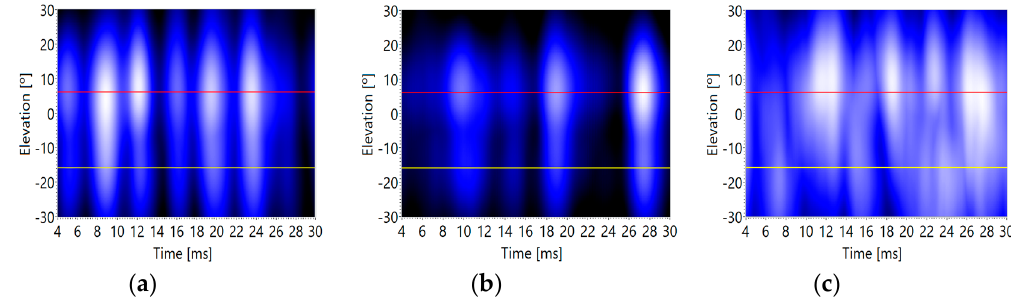
Figure 14. Acoustic image section (elevation/time) versus background noise levels: ( a ) minimum, ( b ) medium and ( c ) maximum.